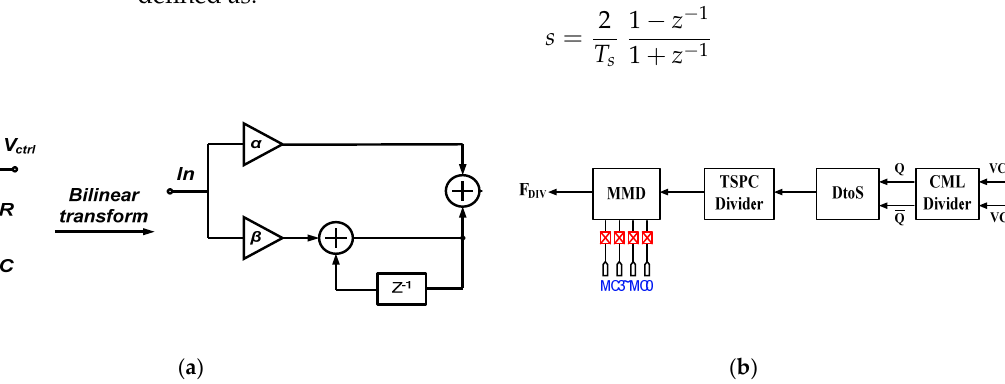
Figure 5. ( a ) The delay chain of the finetune TDC; and ( b ) the structure of finetune TDC. The first-order PI circuit is chosen to implement the digital loop filter. Figure 6a illustrates the s-z bilinear analog to digital domain transformation for the first-order passive RC loop filter which is a resistance and a capacitance being connected in series. A digital equivalent circuit of an analog loop filter is known as a proportional-integral (PI) controller and is chosen to implement the digital loop filter. The parameter α and β in this circuit are the proportional gain and integral gain, respectively [12]. All parameters of the digital loop filter can be defined and made a checking calculation [13]. The bilinear transform can be defined as: